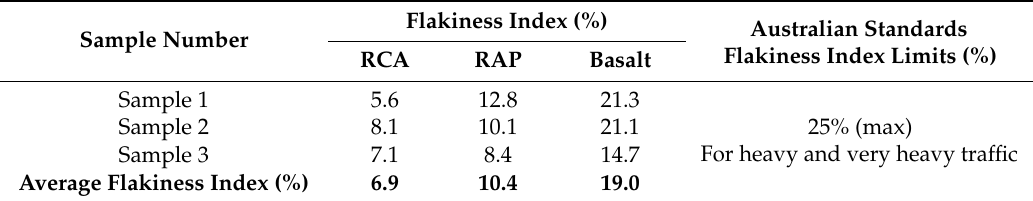
Table 3. The Results of Flakiness Index Test for Coarse Aggregates and Flakiness Index Limits for Dense Graded Asphalt Based on Australian Standards.